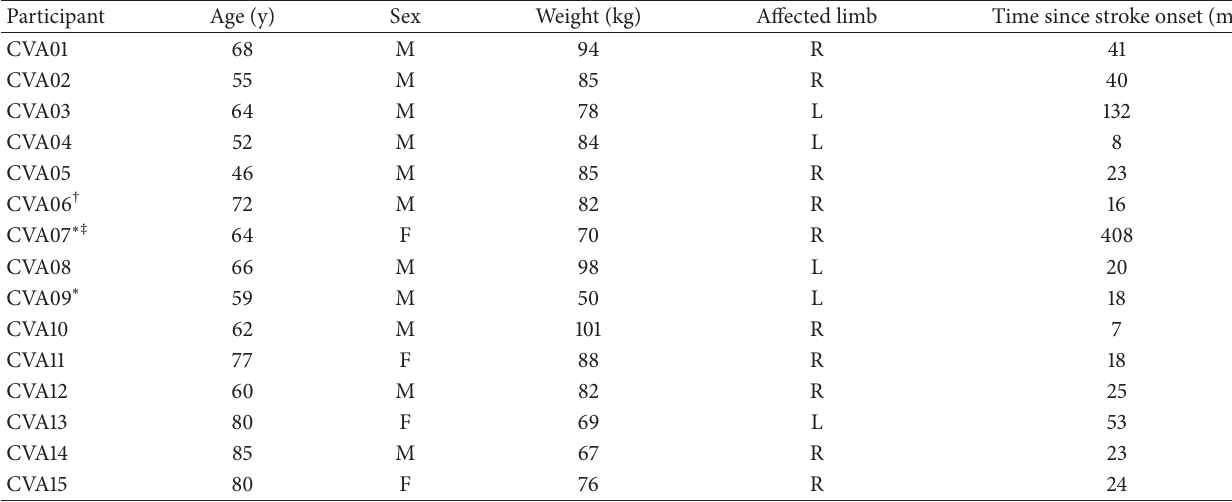
Table 1: Participant characteristics.